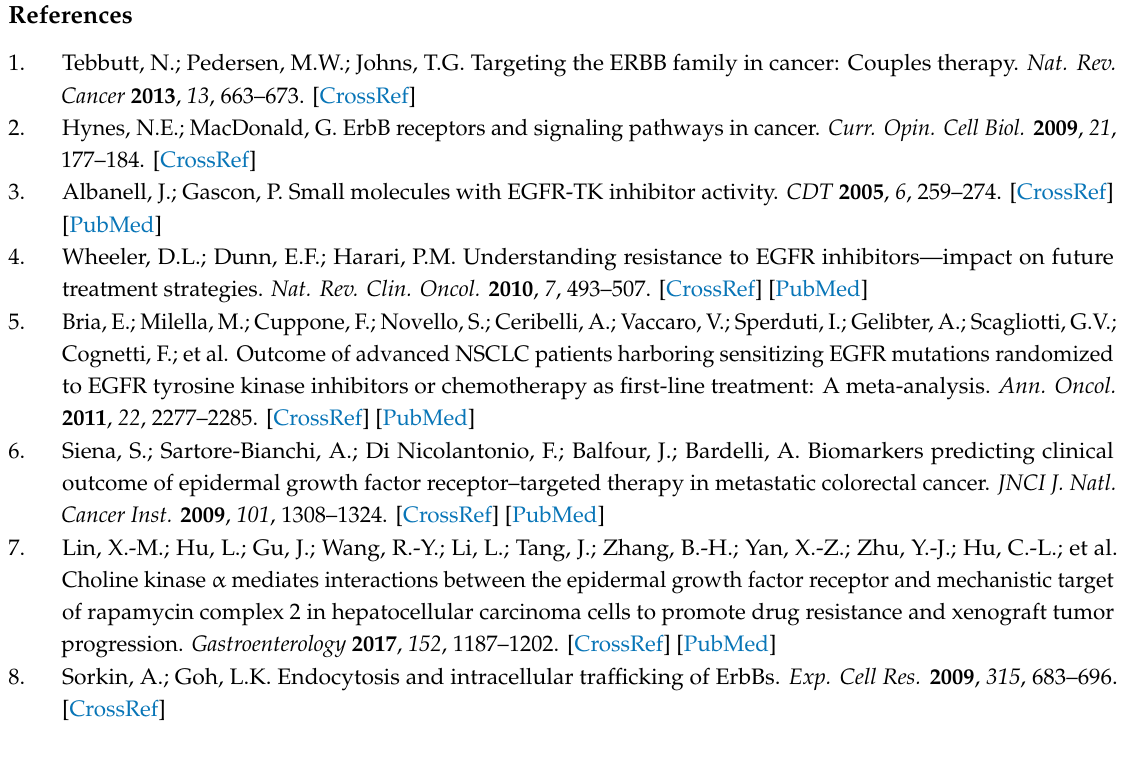
rLZ-8, Figure S9: Impact of rLZ-8 on internalization of BSA, Figure S10: rLZ-8 was not co-localization with other receptors, Figure S11: The tumor inhibitory rate of rLZ-8 was correlative with the EGFR expression in PDX models, Figure S12: IHC detection of tumor tissues of PDX models, Figure S13: IHC detection of rLZ-8 treating on mice, Figure S14: EGFR siRNA inhibited the internalization of rLZ-8, Figure S15: Mapping the rLZ-8 / EGFR binding interface by CXMS, Figure S16: Biacore analysis of EGFR and rLZ-8, Figure S17: Binding of EGFR and rLZ-8 mutant on cell membrane, Figure S18: The e ff ect of TriCEPS on the internalization of rLZ-8, Figure S19: Western blot files with molecular weight markers, Supplementary Material 1: Descriptions macropinocytosis characterization induced by rLZ-8, Supplementary Material 2: Descriptions of Rab7 activation and CaCl 2 influence, Supplementary Material 3: Descriptions of immunohistochemistry and siRNA, Supplementary Material 4: Descriptions of